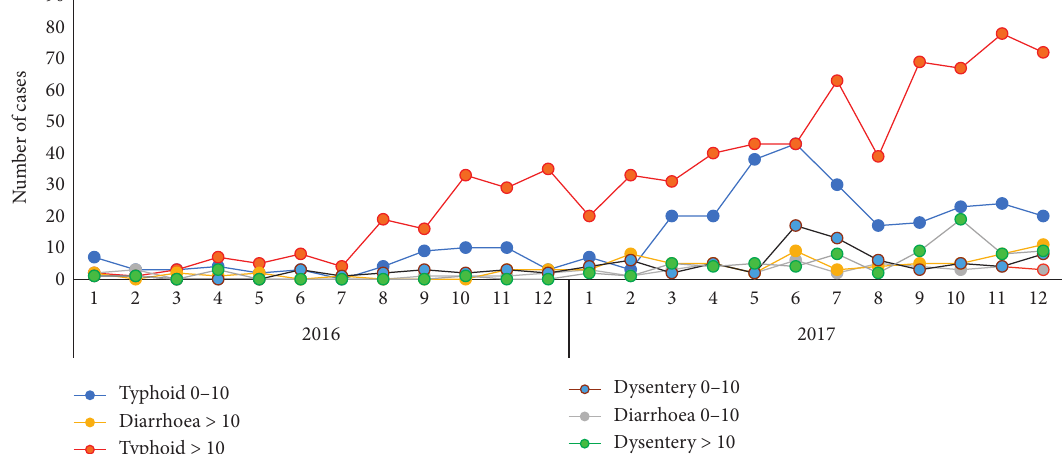
Figure 8: Monthly distribution of waterborne diseases recorded in Bangolan between 2016 and